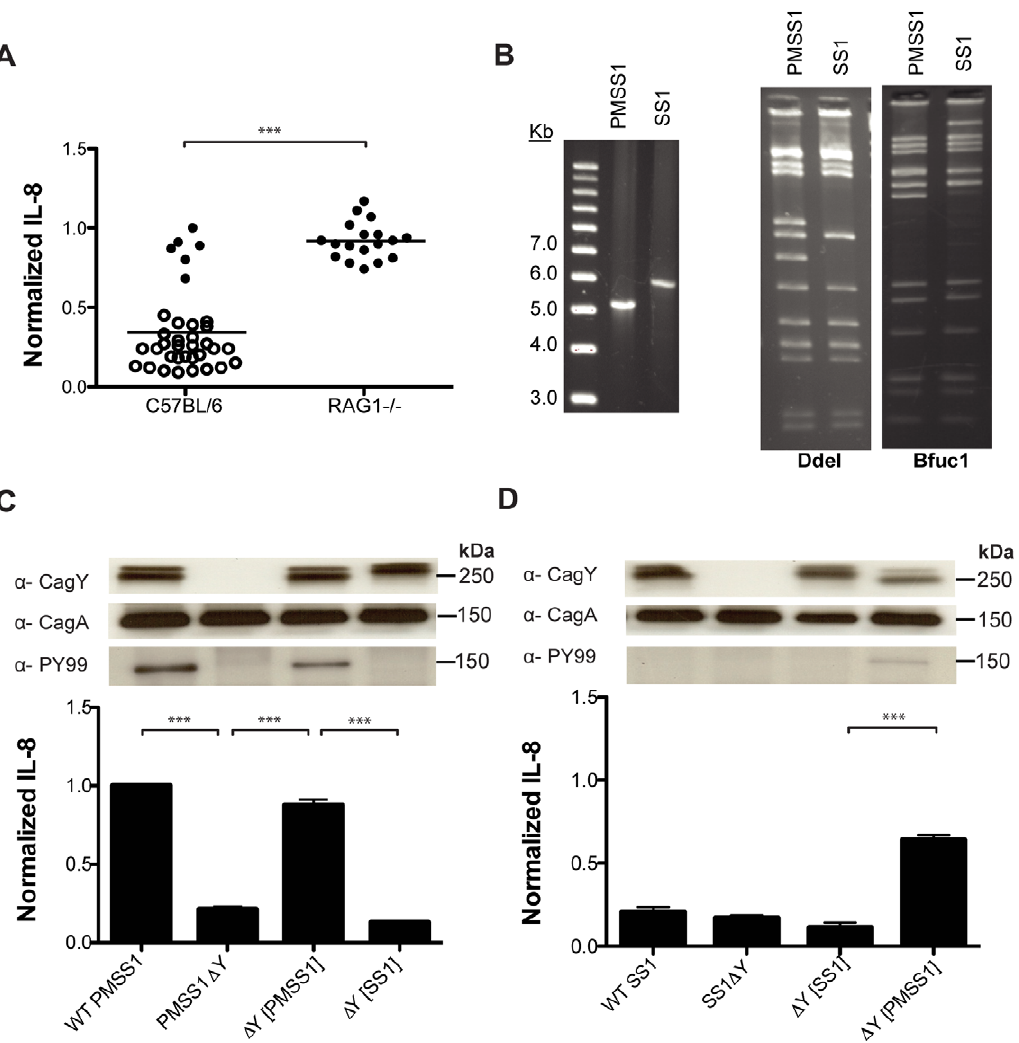
Figure 9. Mouse adapted H.pylori strain SS1 expresses a CagY that is not functional for induction of IL-8 or translocation of CagA. (A) H. pylori was isolated from C57BL/6 WT or RAG1 2 / 2 mice (N=3–6/time point) 8 weeks after experimental infection with H. pylori PMSS1. Individual colonies (3–6/mouse) were co-cultured with AGS cells, and ELISA was used to measure IL-8 levels, which were normalized to the PMSS1 positive control (line=mean). Each data point represents the results from a single colony. Induction of IL-8 in colonies isolated from WT mice was significantly lower than in RAG1 2 / 2 mice, and was associated with changes in cagY PCR-RFLP (open circles). (B) cagY in H. pylori strain SS1 is larger than that in the progenitor strain PMSS1, and has a different fingerprint on PCR-RFLP. (C) Deletion of cagY from WT H. pylori PMSS1 reduced the induction of IL-8 and eliminated translocation of CagA, which were recovered when the WT PMSS1 cagY gene was restored ( n Y[PMSS1]. However, replacement of the PMSS1 cagY gene with that from H. pylori SS1 ( n Y [SS1]) showed reduced levels of IL-8 and no CagA translocation. (D) WT H. pylori SS1 showed little induction of IL-8 and no CagA translocation, and it was unaffected by deletion of cagY or restoration of the WT SS1 cagY allele. However, replacement of the WT SS1 cagY allele with that from PMSS1 markedly increased IL-8 induction and CagA translocation, though not to the level of PMSS1. All assays represent the mean 6 SEM of 3 replicates. ** P , 0.01; *** P , 0.001.